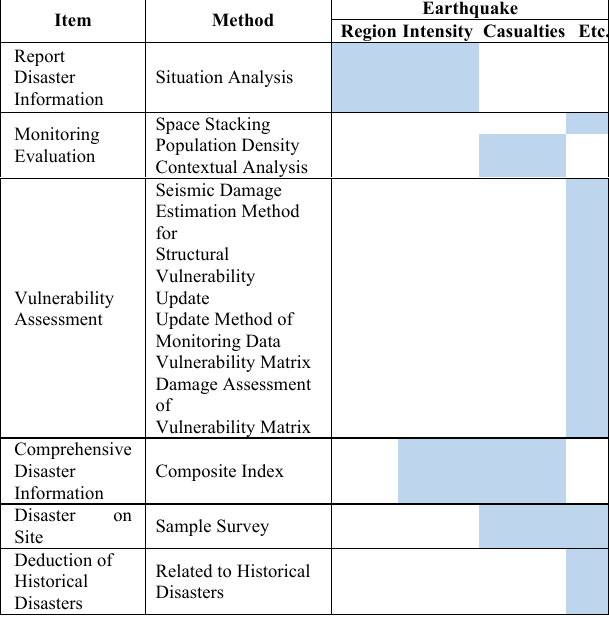
Table 1 . Evaluation model of earthquake disaster.